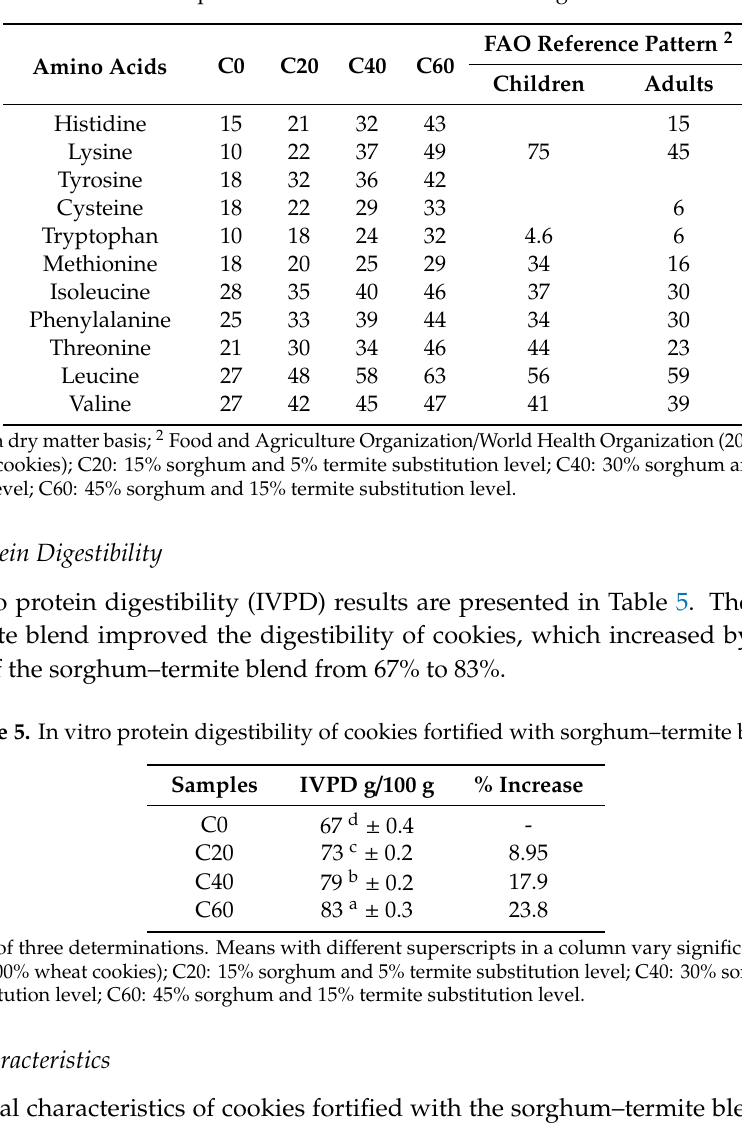
Table 4. Essential amino acid composition of cookies fortified with sorghum–termite blend (mg / 100 g) 1 .